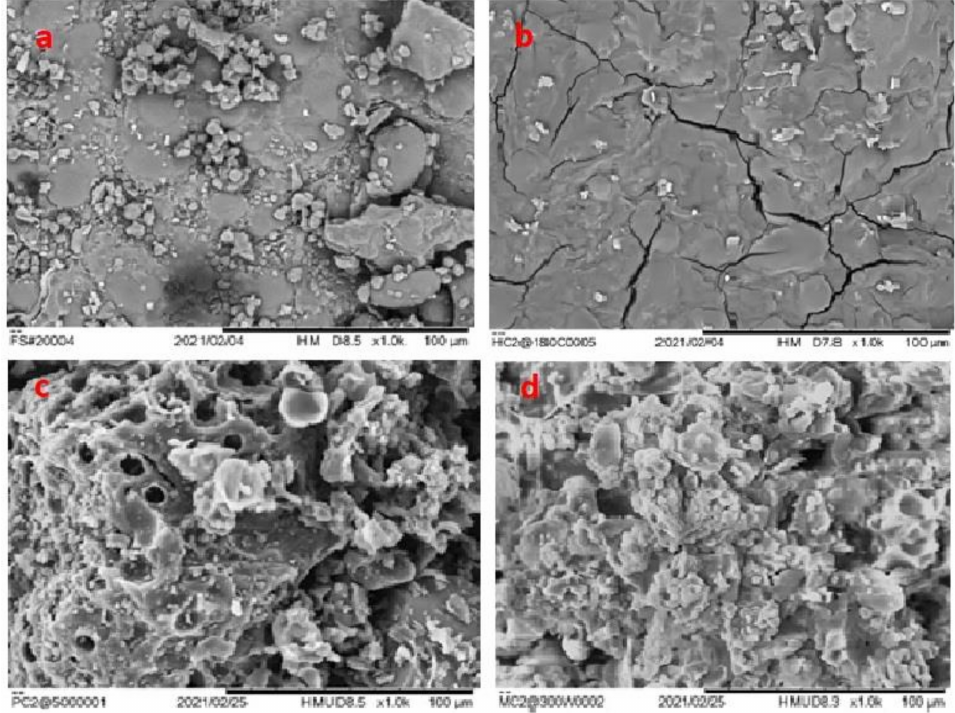
Figure 3. SEM images for ( a ) Feedstock, ( b ) HTC180, ( c ) PY500, and ( d ) MW300 at 1000 × magnifica- tion